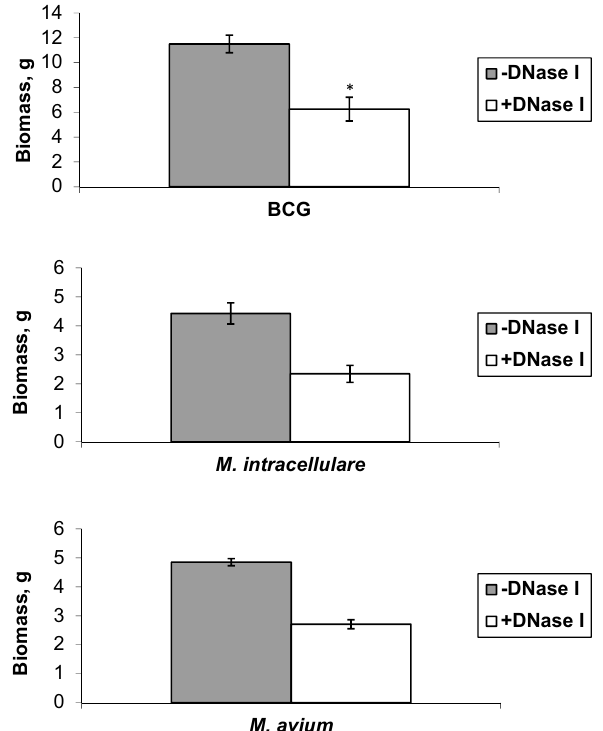
Figure 4. Biomass of mycobacterial pellicles treated with DNase I or not. Five weeks after incubation of BCG ( a ) , M. intracellulare ( b ), and M. avium ( c ) in Sauton medium with or without the addition of DNase I and wet weights of pellicle were measured. Mean ± SD (n = 4). * p < 0.05, compared to a biomass of DNase I untreated BCG (− DNase I).